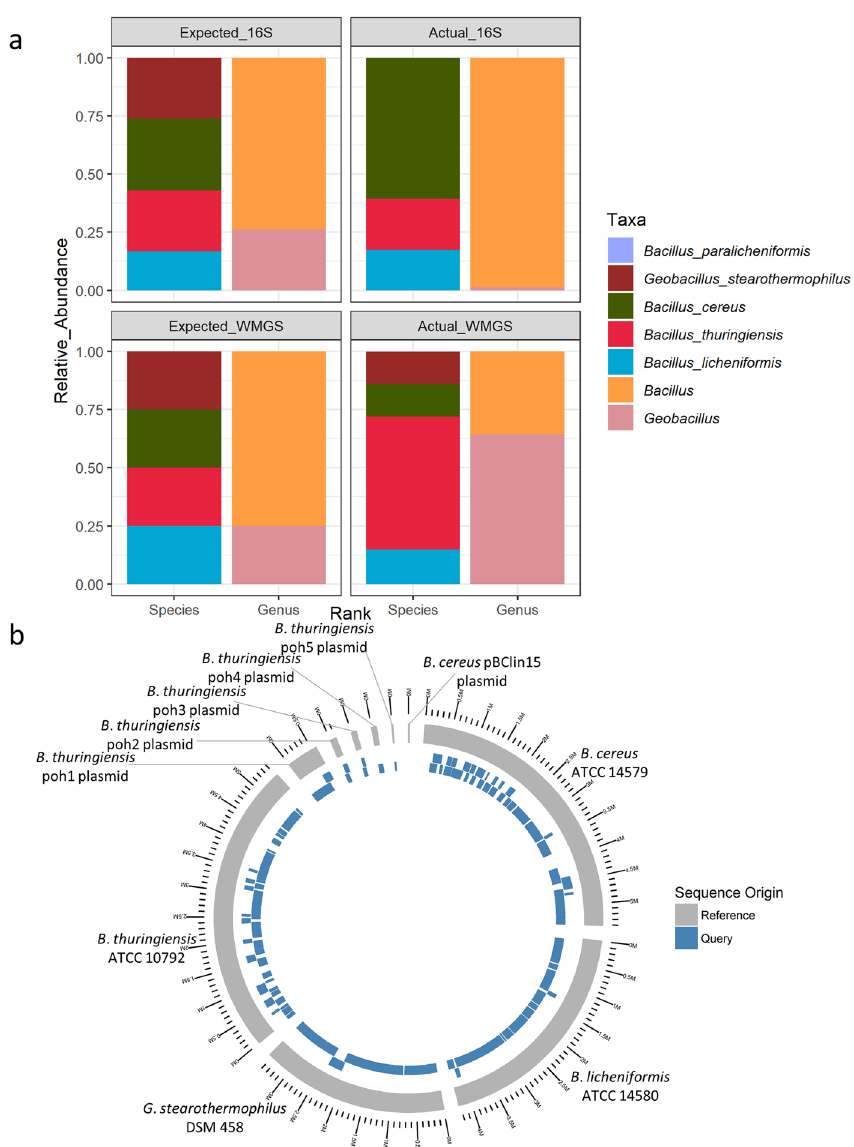
Fig. 1 Mock community analysis. MinION sequencing followed by MEGAN taxonomic classi fi cation of a simple mock community. a Taxonomic classi fi cation following 16S and whole metagenome (WMGS) sequencing. Also shown are expected relative abundances. b De novo assembly of genomes by the canu assembler, followed by mapping back to original known genomes, to illustrate coverage at 97% identity. 4 genomes, with 6 plasmids illustrated, of which 4 genomes and 5 plasmids had sequences aligned at 97%